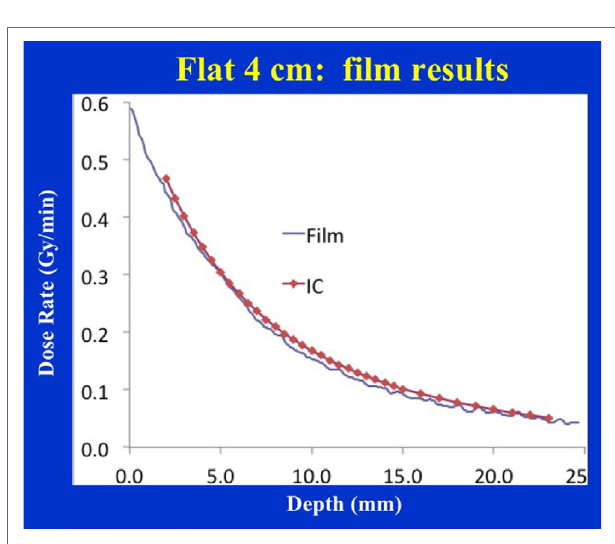
FigUre 8 | Film vs. ion chamber depth dose comparison for a 4 cm diameter flat applicator.